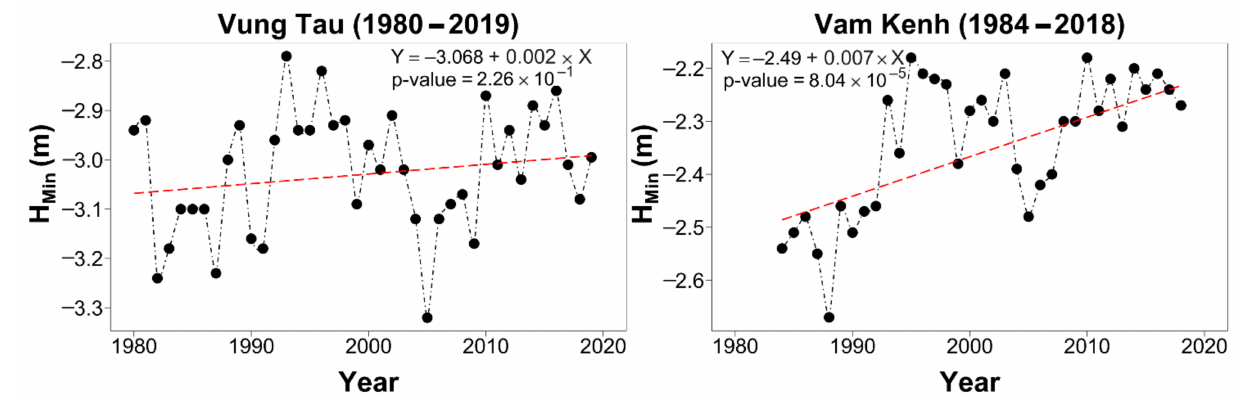
Figure 4. Annual minimum water level trends H min .